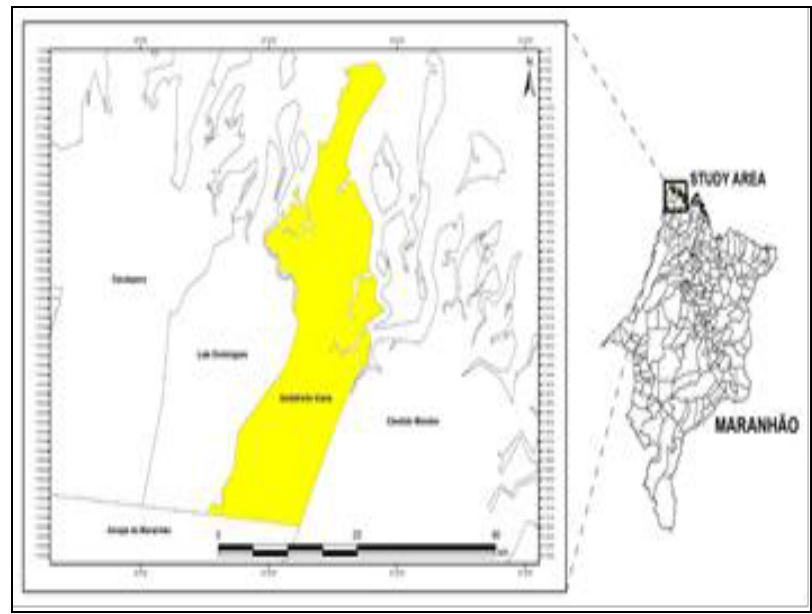
Figure 1: Location of the study area in Godofredo Viana, Maranhão state, Brazil.